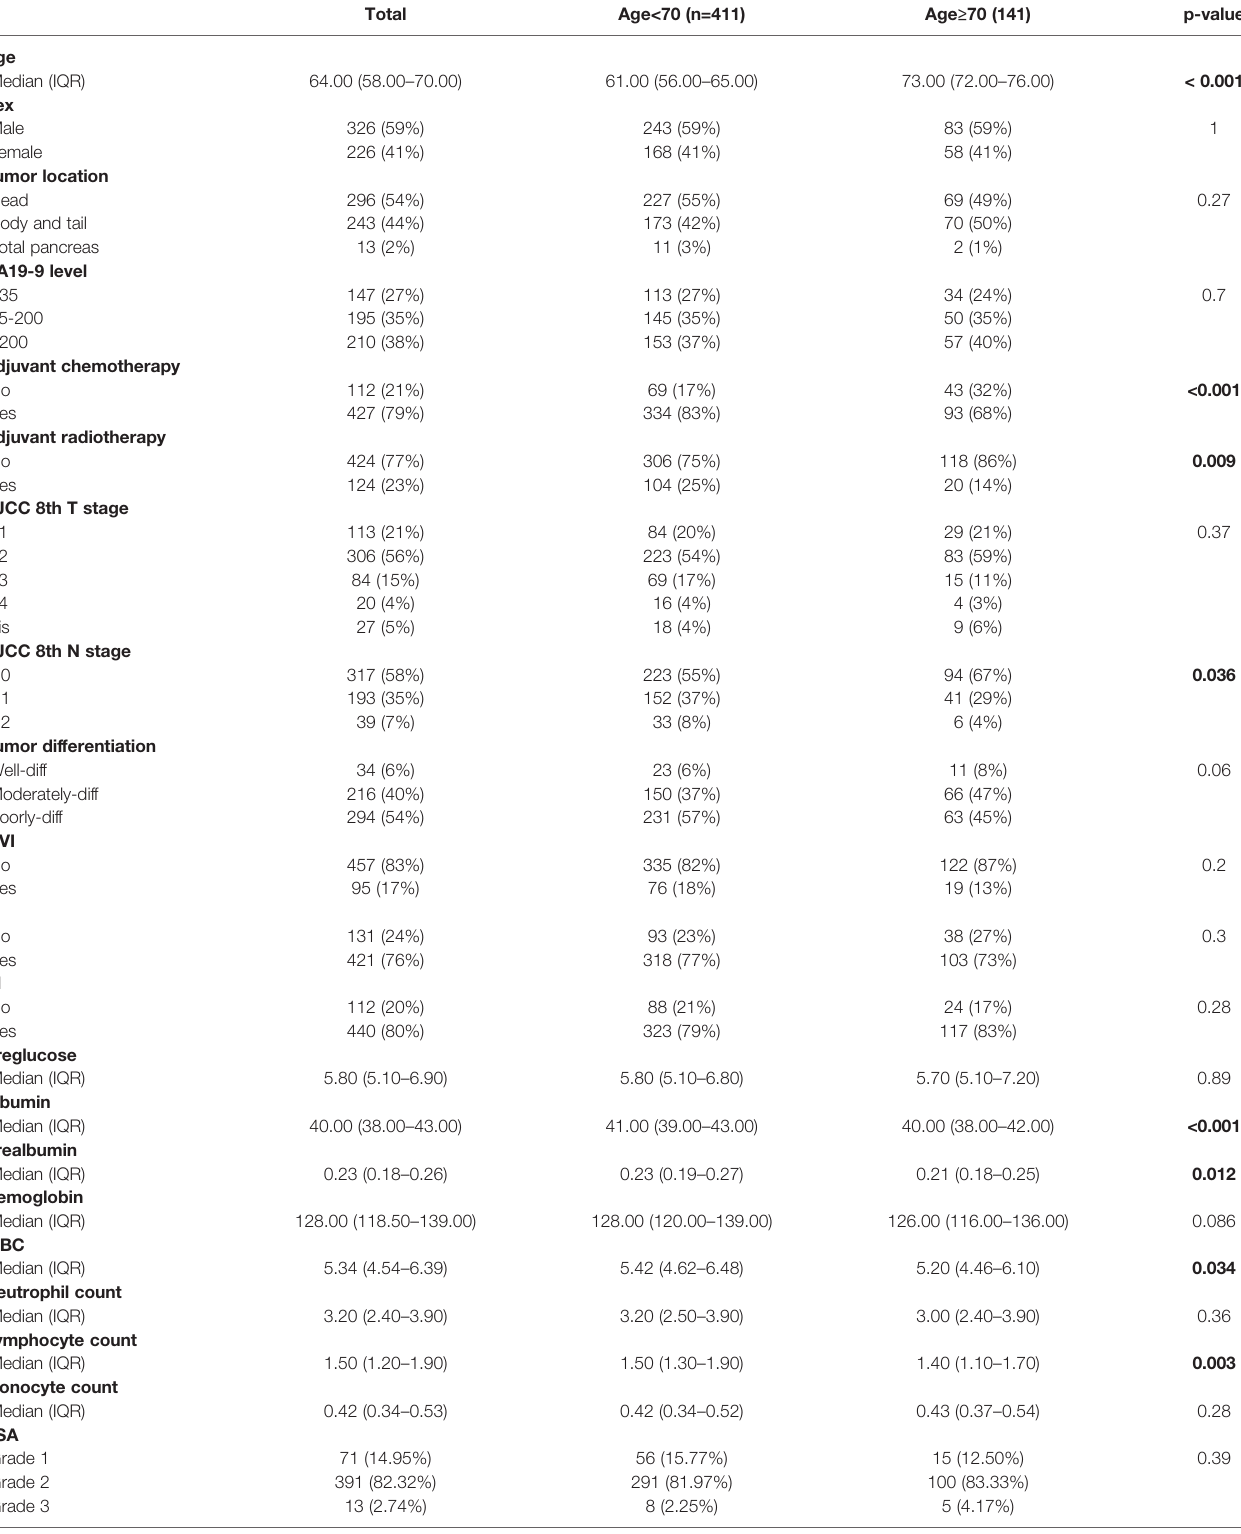
TABLE 1 | Baseline characteristics of the study population